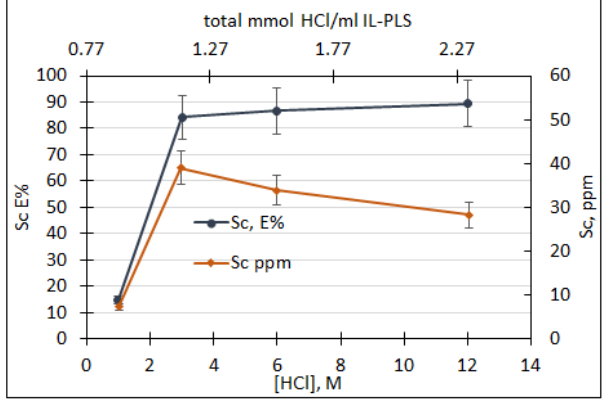
Figure 5. Scandium extraction and scandium concentration in aqueous phase during second stripping procedure as a function of the acid concentration and at constant volume ratio 1:8.